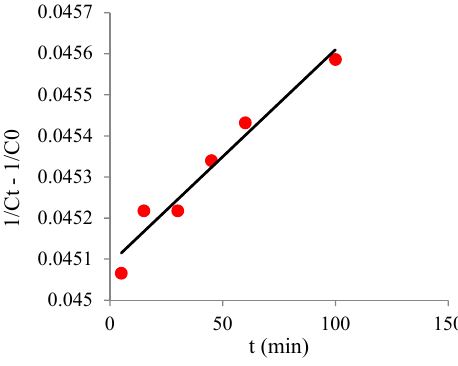
Fig. 16: Pseudo-second-order plot of cadmium adsorption onto polypyrrole/titanium dioxide